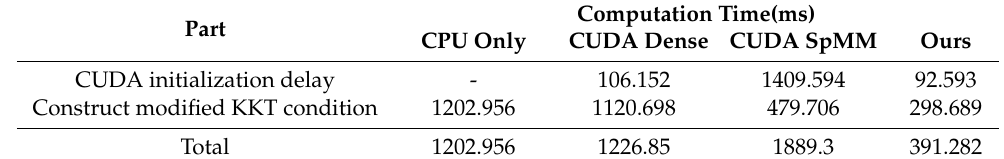
Figure 5. The computation time comparison result graph of the construct modified KKT condition part. Table 5. The computation time comparison results of the construct modified KKT condition part.